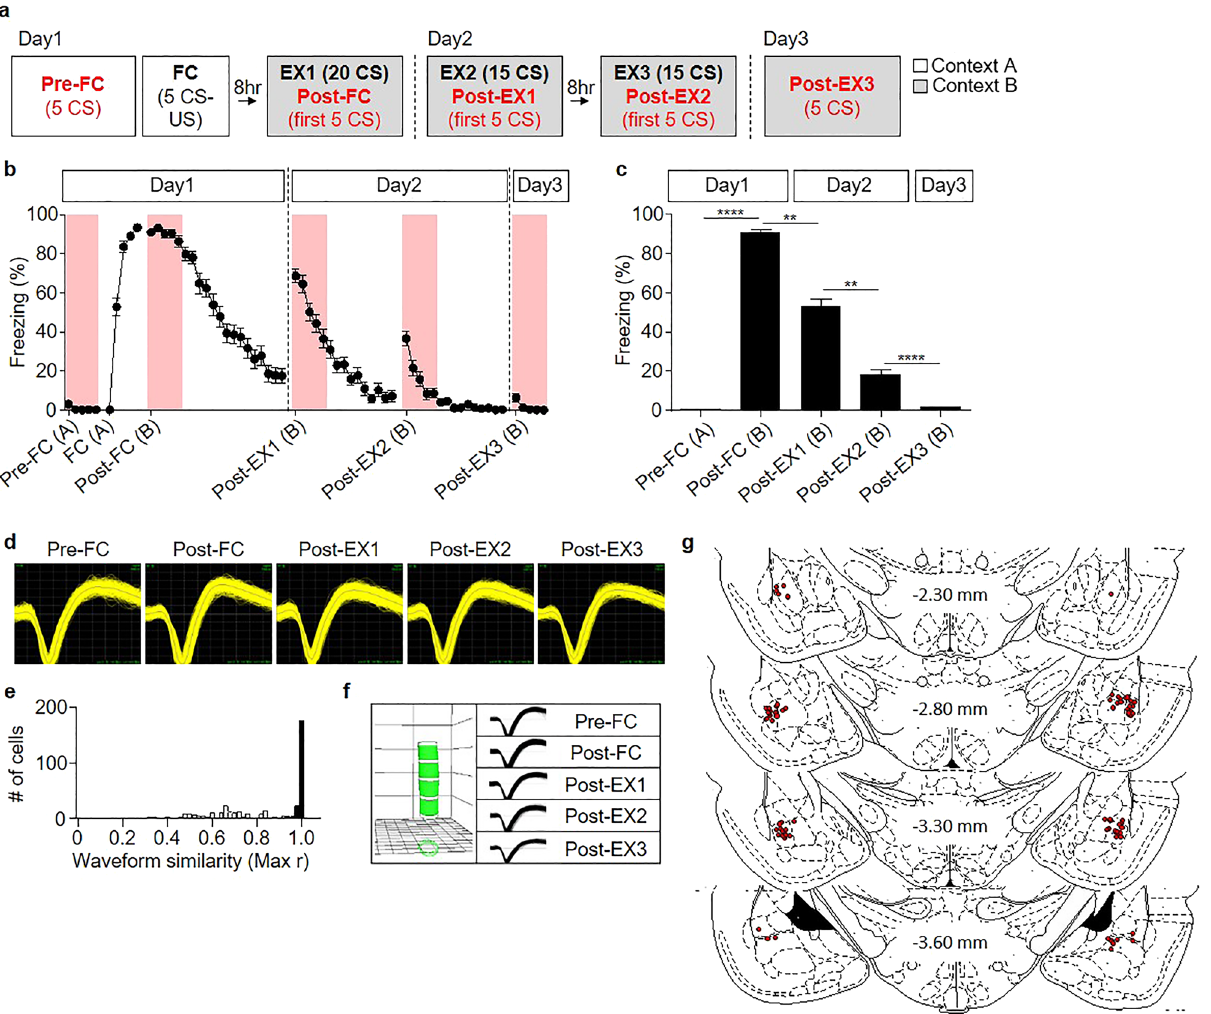
Figure 1. Long-term single-unit recordings in the BA L throughout fear conditioning (FC) and extinction (EX). ( a ) The behavioral procedure used in the electrophysiological experiment. Pre-FC and FC sessions were conducted in context A (white) and EX1-3 and Post-EX3 were conducted in context B (gray). ( b ) Averaged learning curves of the behavioral sessions. Conditioned freezing to each CS was measured and averaged among rats throughout the behavioral training. The context where each behavioral session was taken is depicted as A for context A and B for context B. ( c ) Averaged freezing responses during the first five conditioned stimulus presentations in each session. The error bars indicate the standard error of the mean. ** p < 0.005; **** p < 0.00001. ( d ) Representative waveforms of a neuron recorded from a single electrode throughout the behavioral training period. The waveforms were visualized using Offline Sorter, Version 3.3.5 (Plexon, Dallas, TX, www. plexon. com). ( e ) Quantitative evaluation of waveform similarity from the units recorded across all behavioral sessions. Randomly selected waveforms were used as controls (white bars). ( f ) Verification of the long-term stable single-unit recordings using principal component space cylinders. A straight cylinder suggests that the same set of single units has been recorded in different behavioral sessions. The space cylinders were created using WaveTracker, Version 1.15 (Plexon, Dallas, TX, USA, www. plexon. com). ( g ) Histological verification of the electrode placement in all experiments. The atlas was derived from open atlas Brain maps 44